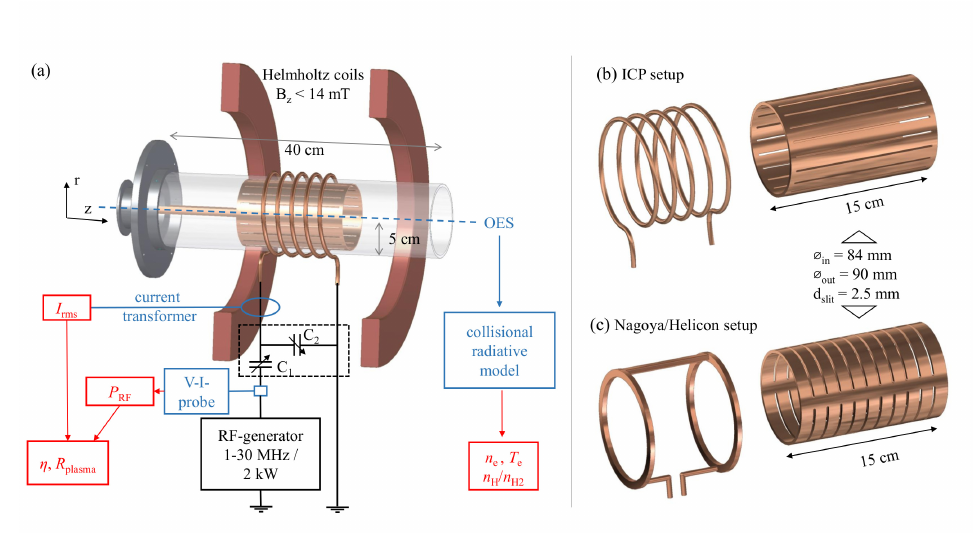
Figure 1. ( a ) Experimental setup and applied diagnostics. In ( b ), the RF coil and the internal Faraday shield utilized in the ICP configuration are shown, in ( c ) the Nagoya type-III antenna with the corresponding Faraday shield for the helicon setup is